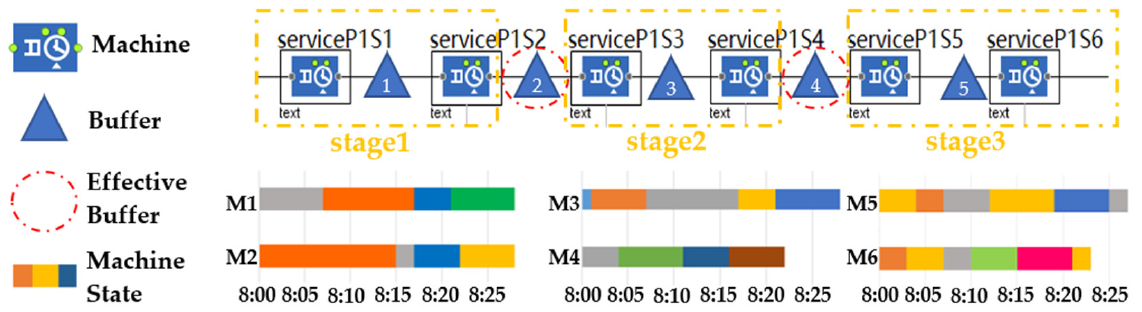
Appl. Sci. 2022 , 12 , x FOR PEER REVIEW Figure 3. The effective buffering determination flowchart. Figure 3. The effective buffering determination flowchart.